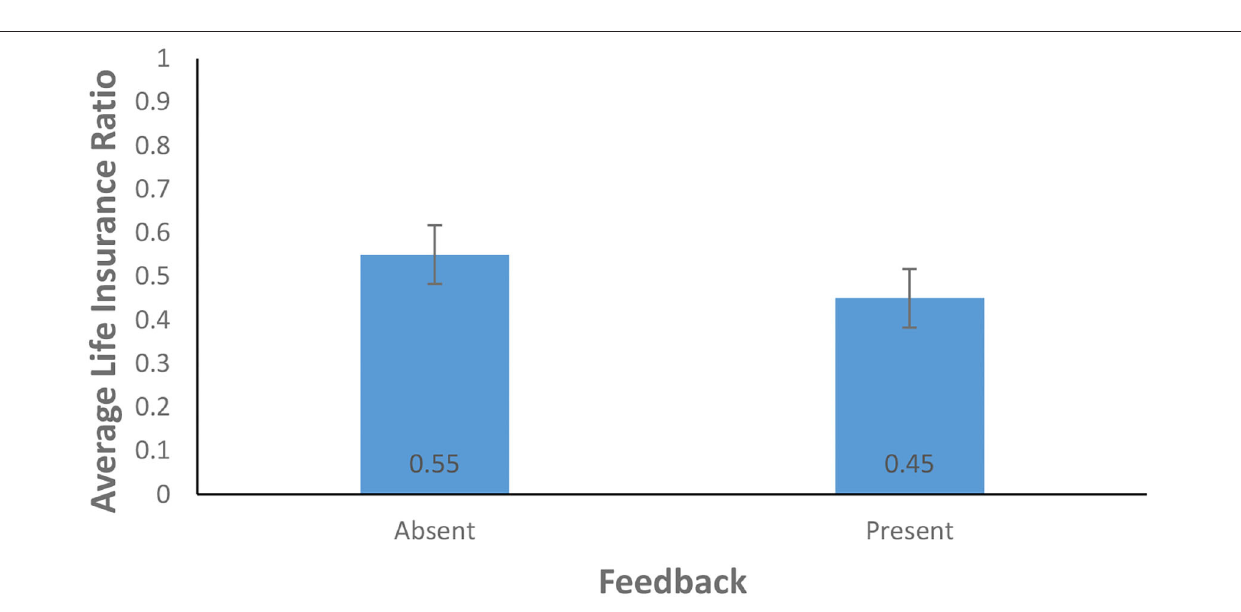
Investment Ratios Over